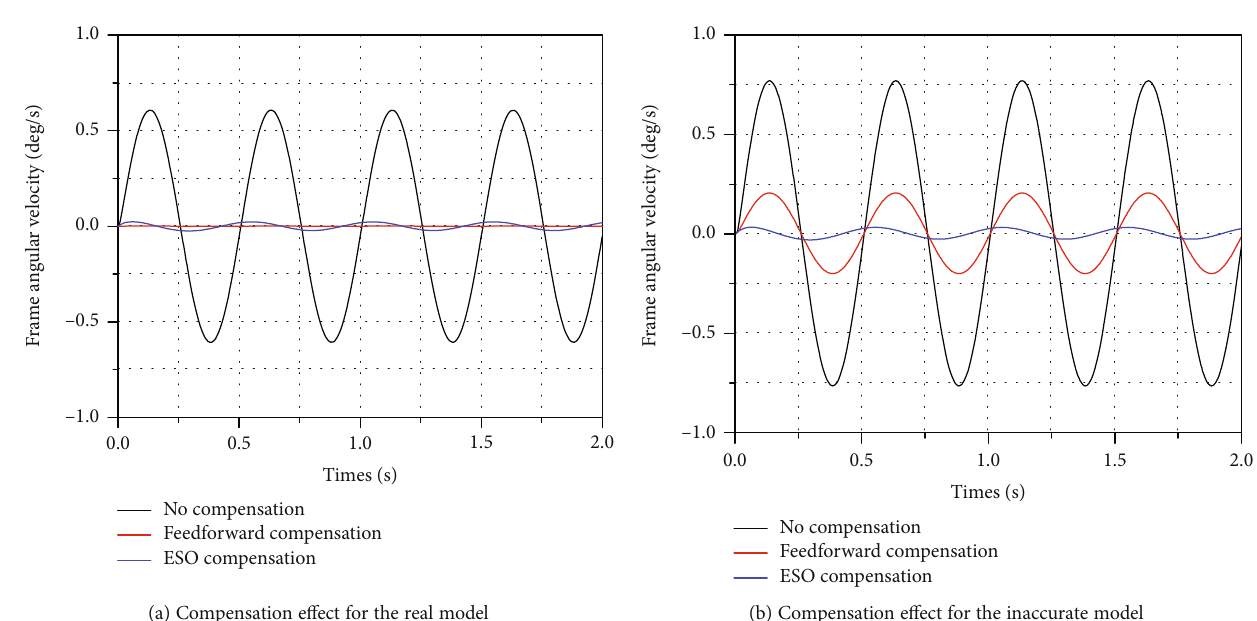
: 15 and k = 0 : 8 . ω = 0 n